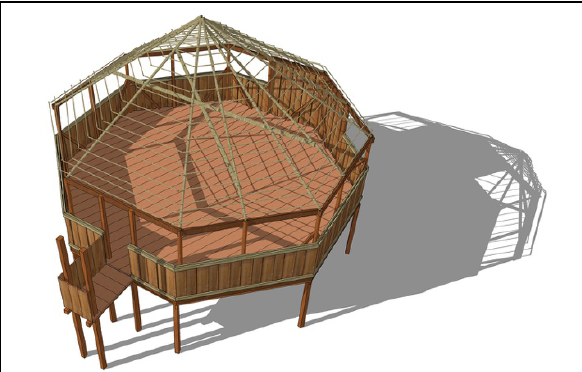
Figure 20. 3D drawing of House of Justice in Guabo de